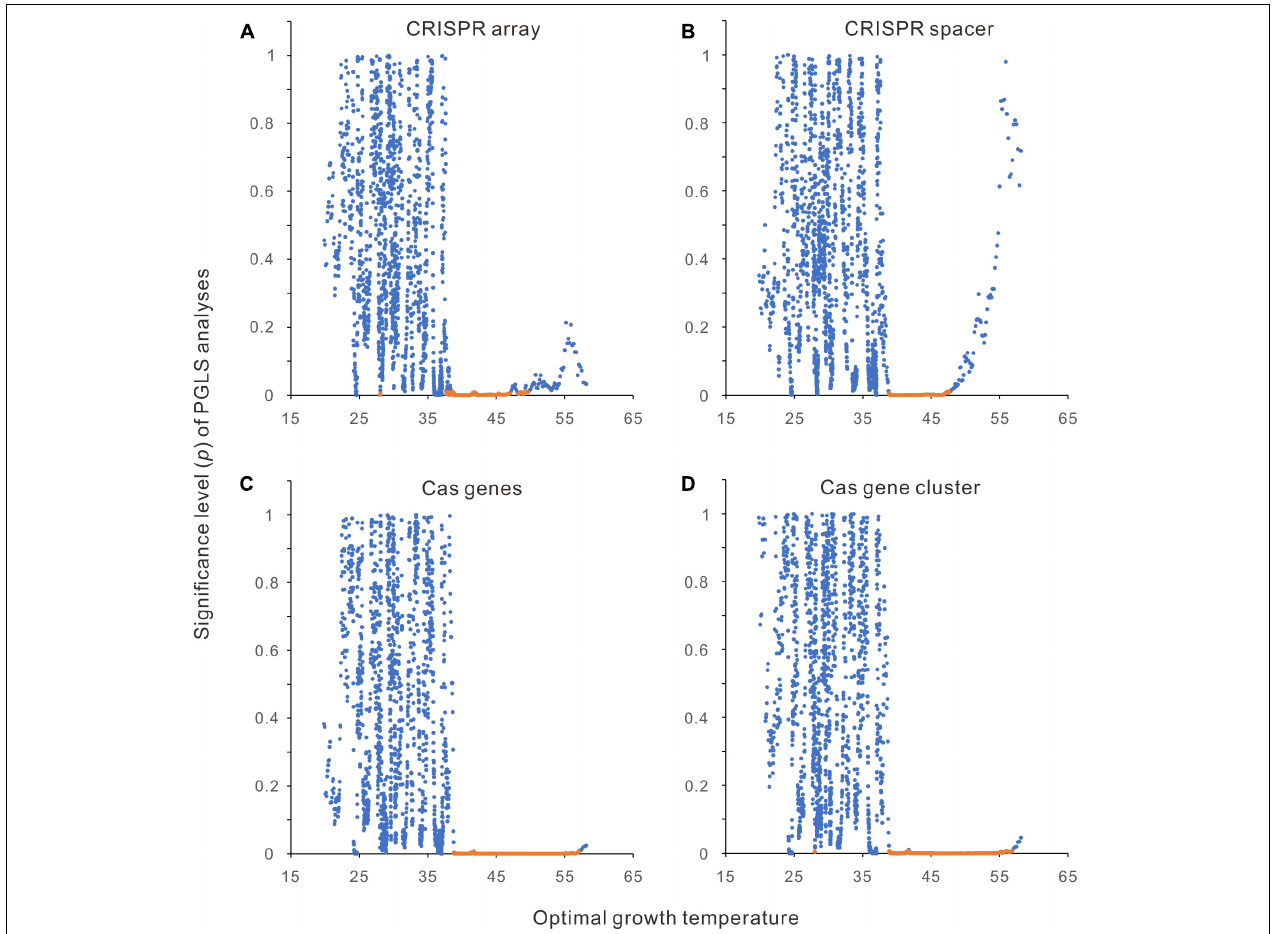
FIGURE 4 | Segmental phylogenetic generalized least squares (PGLS) regression analysis of the relationships between CRISPR-Cas abundances and optimal growth temperatures (Topt). (A) CRISPR arrays. (B) CRISPR spacers. (C) cas genes. (D) cas gene clusters. The 2944 bacteria were aligned along the Topt axis. Two hundred neighboring samples were taken in each round of PGLS analysis. The average Topt of each 200 samples was presented in the scatter charts. The regression results with positive slopes and < 0.01 significance values are